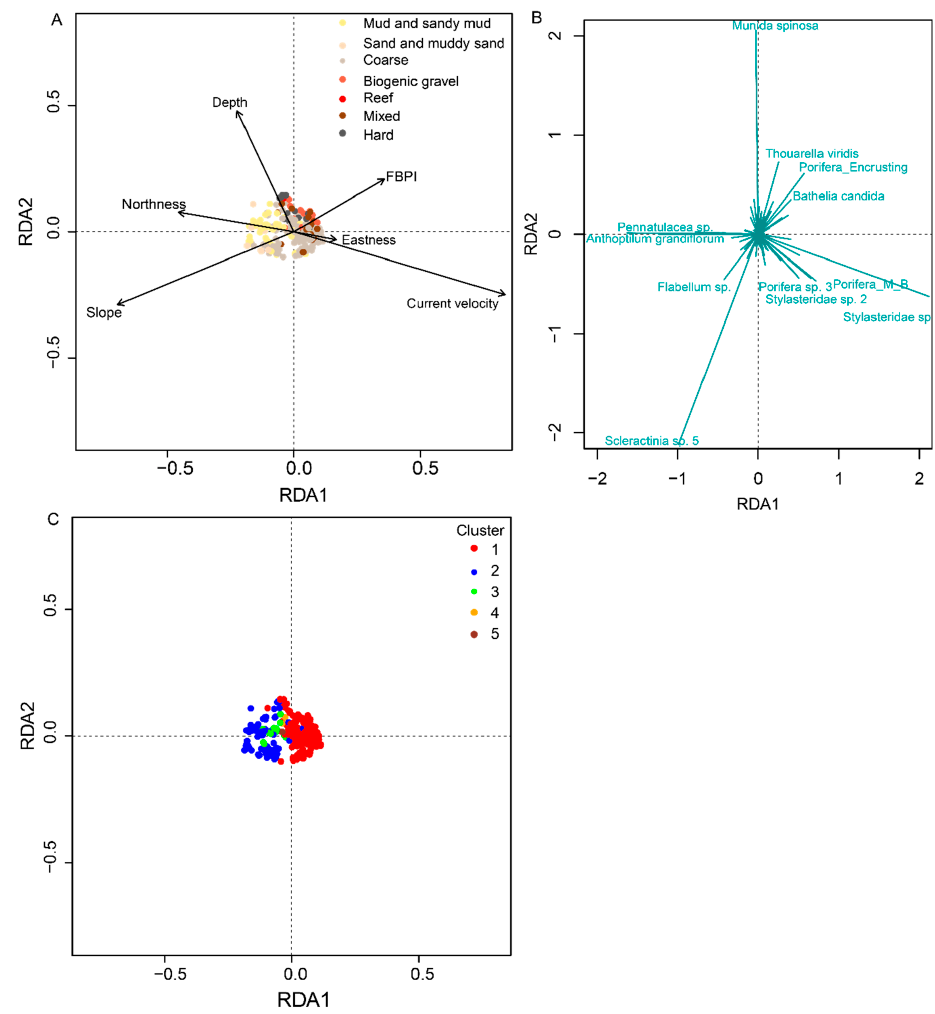
Figure 5. Canonical redundancy analysis of a Hellinger distance matrix of transformed morphospecies density data and selected environmental variables. For clarity, the triplot is displayed in three separate plots with varying axis limits. ( A ) Environmental variables and sites colour coded by substratum type. ( B ) Morphospecies data, only fauna with the strongest effect are labelled. ( C ) Sites colour coded to represent hierarchal clustering. The vector arrowheads represent high, the origin averages, and the tail (when extended through the origin) low values of the selected environmental variables. Sites are represented by circles. Sites close to one another tend to have similar faunal composition that those further apart. Table 2. Clusters identified from multivariate hierarchal clustering analysis with associated envi- ronmental parameters, number of samples represented by each cluster (N), and SIMPER